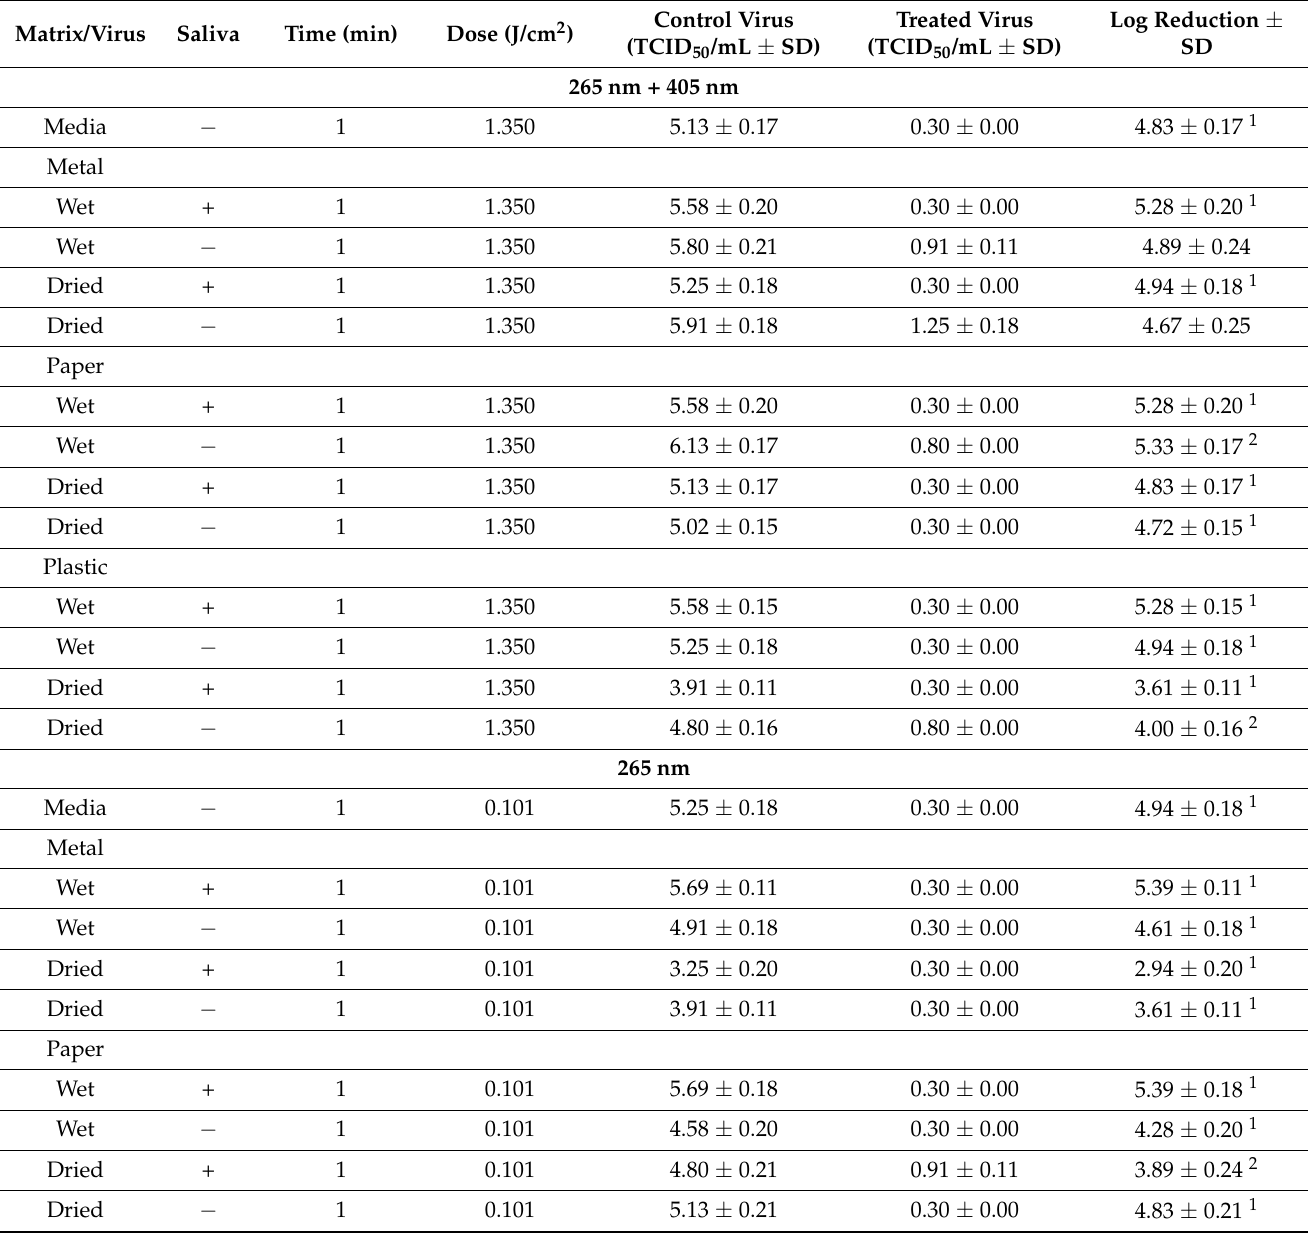
with either wet or dried FIPV in the presence or absence of artificial saliva were exposed to a comparable intensity of light (1686 µ W/cm 2 for 265 nm and 1947 µ W/cm 2 for 254 nm) for 1-min. Infectious FIPV was not recovered from any of the matrices after treatment of the wet virus with light at either 265 nm or 254 nm, with at least a 4-log reduction in titer observed under all test conditions (Table 1). Treatment of the dried virus with individual or dual 265 nm + 405 nm lights was virucidal under most, but not all, testing conditions, with the poorest virucidal effect exhibited by 265 nm light against the virus spotted on plastic and paper (Table 1). Table 1. Time and dose at which a 4-log reduction in titer was reached for feline infectious peritonitis virus (FIPV) in media as well as for dried or wet virus spotted on three different surfaces (metal, paper, plastic) in the presence and absence of artificial saliva, after exposure to UVC light at 254 nm, 265 nm, or to dual 265 nm + 405 nm light. When a 4-log reduction was not observed, the highest log reduction achieved is shown. The light was placed at a distance of 25 cm from the virus.